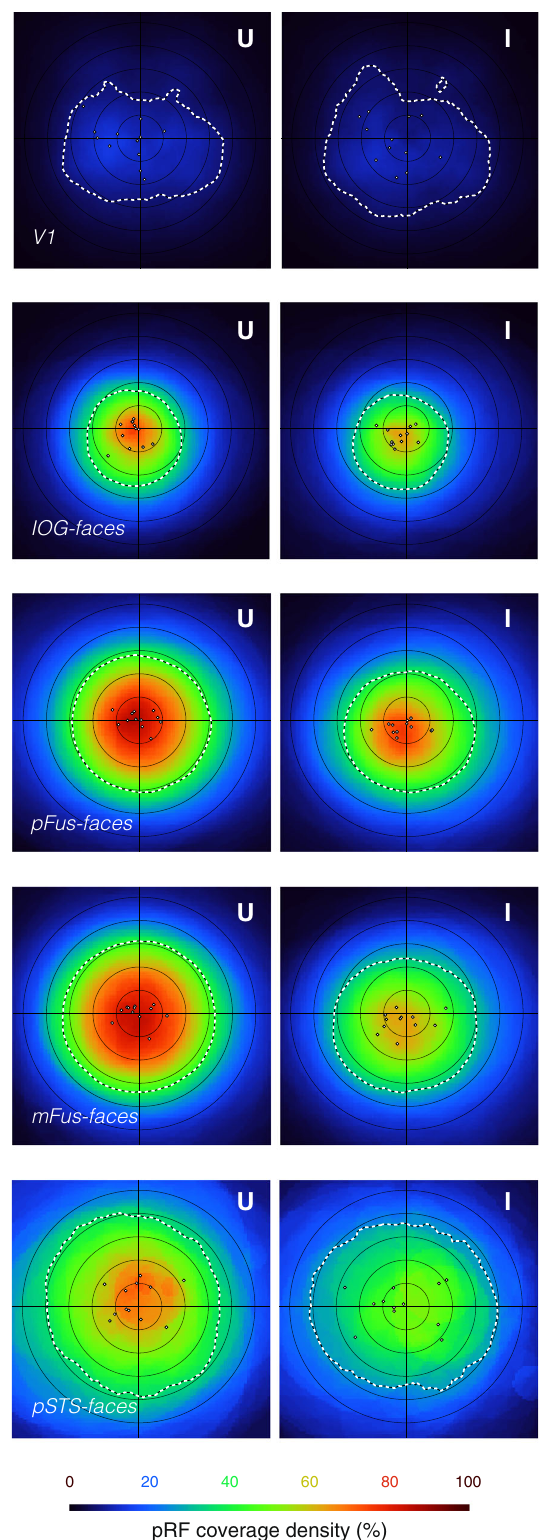
visual fi eld coverage (Fig. 5). Coverage for the latter spans a smaller portion of the visual fi eld (signi fi cant change in full- width-half-max area: post-hoc t (11) = 2.79, p = 0.017) and is shifted downward relative to the former (signi fi cant change in center-of-mass Y: post-hoc t (11) = 3.34, p = 0.0066, but not